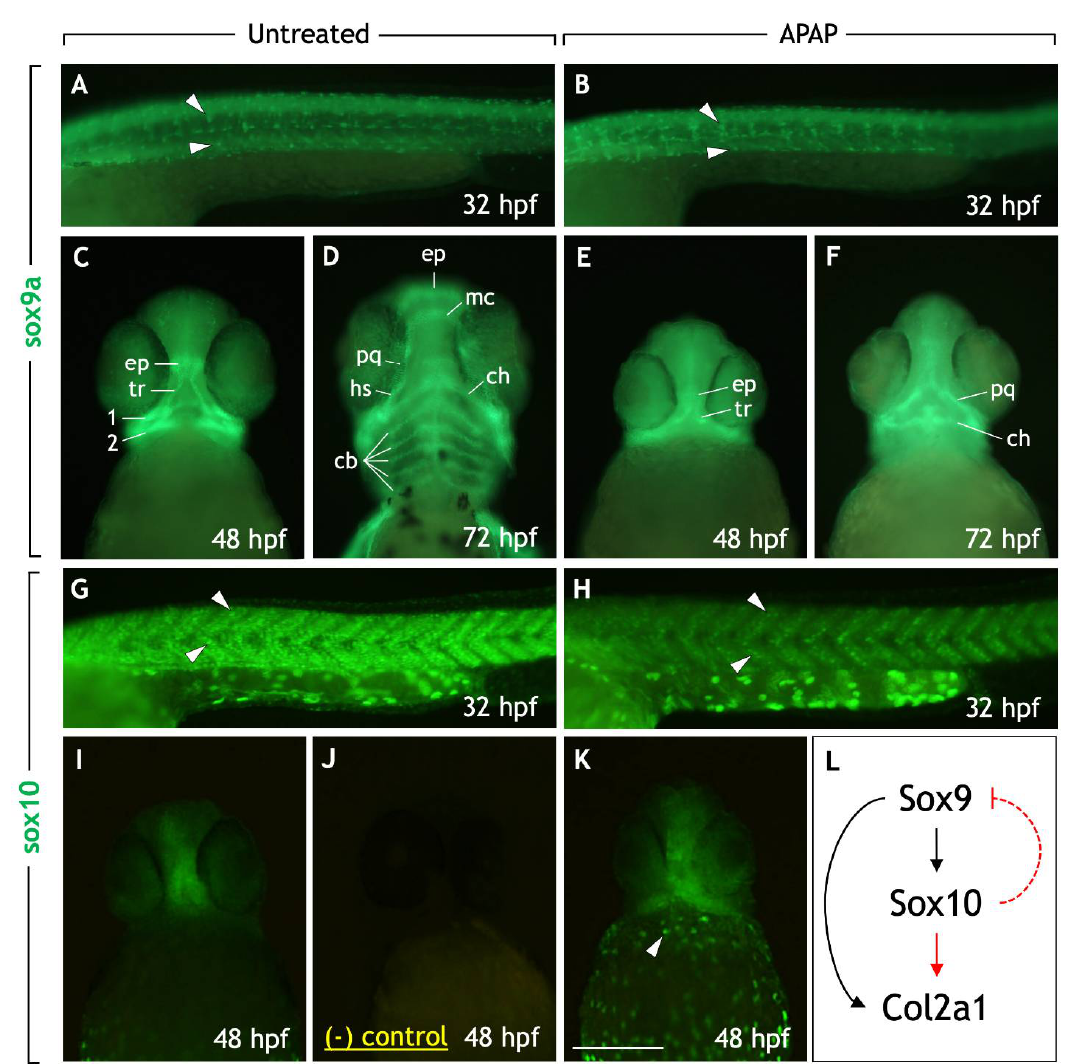
Figure 6. Neural crest cell markers sox9a and sox10 are expressed in trunk and cranial neural crest cells in APAP-treated embryos. ( A – K ) Lateral views ( A , B , G , H ) or ventral views ( C – F , I – K ) of embryos processed for sox9a ( A – F ) or sox10 ( G – K ) immunohistochemistry. sox9a-positive trunk NC cells can be seen migrating ventrally in both untreated ( A ) and APAP-treated ( B ) embryos at 32 hpf (white arrowheads). In the head at 48 hpf ( C ) and 72 hpf ( D ), sox9a labels NC-derived prechondrogenic cells. In APAP-treated embryos ( E , F ), sox9a expression is reduced due to miss- ing viscerocranium/pharyngeal arch-derived cartilage types. At 32 hpf, sox10-positive trunk NC cells migrate ventrally in streams in untreated embryos (( G ), white arrowheads). In APAP-treated embryos ( H ), sox10-positive cells are reduced in number but follow similar migration paths (white arrowheads). In the head at 48 hpf ( I ), sox10 is expressed along the midline of the neurocranium, verified by comparison with negative control embryos in which the same secondary antibody (but no primary antibody) was applied ( J ). In APAP-treated embryos, sox10 expression is similar but more robust, with enhanced expression along the yolk sac (white arrowhead). ( L ) An overview of a basic gene regulatory network in NC-derived cartilage precursor cells in chick (from Suzuki 2006). Red lines indicate interactions that have not been established in zebrafish. In early NC cells, Sox9 induces Sox10 expression, which in turn downregulates Sox9. In cartilage precursors, Sox10 expression is downregulated causing the recovery of Sox9 expression. Together, both Sox9 and Sox10 positively regulate Col2a1 expression, a marker for differentiating chondrocytes. Abbreviations: ceratobranchial cartilages, cb; ventral ceratohyal, ch; ethmoid plate, ep; dorsal hyosymplectic, dh; Meckel’s cartilage, mc; palatoquadrate, pq; trabecular, tr. Scale bar (in ( K )) for ( A – K ), 200 µ